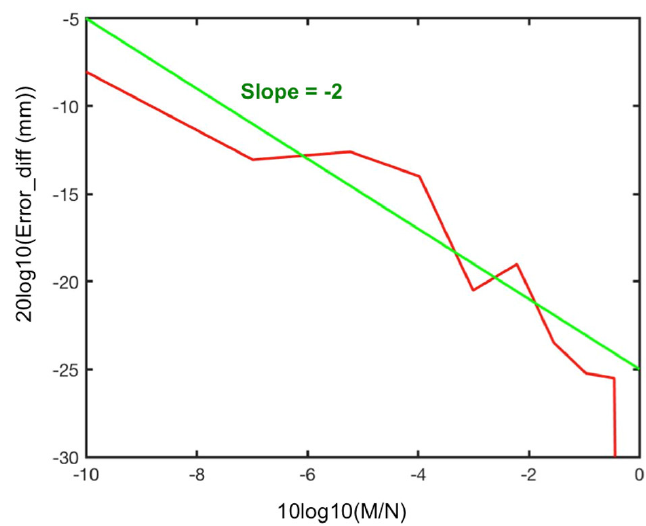
Figure 12. Differential displacement error in function of M/N for a stable point in the test site “Campus”.